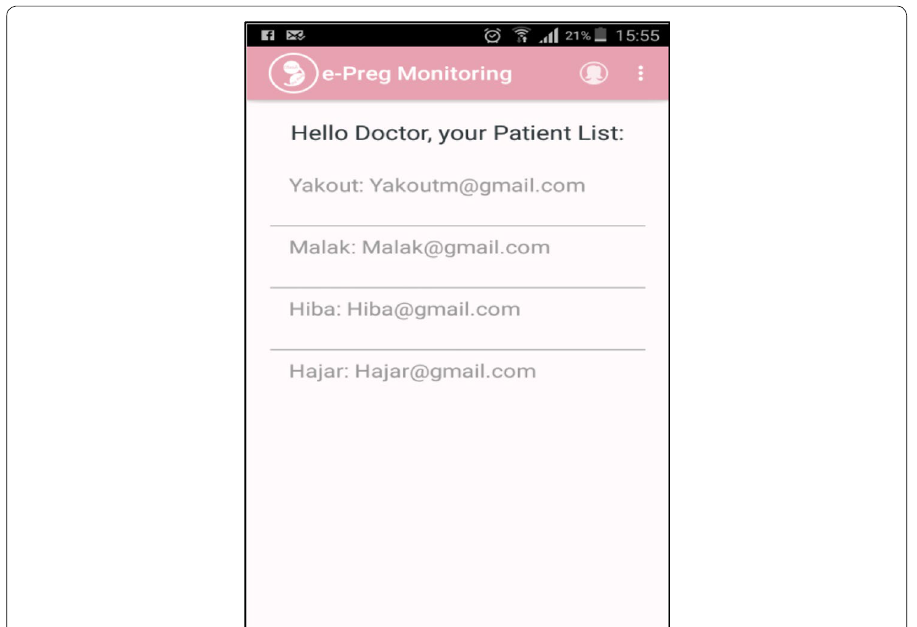
Fig. 8 Screenshot of doctor’s patient list